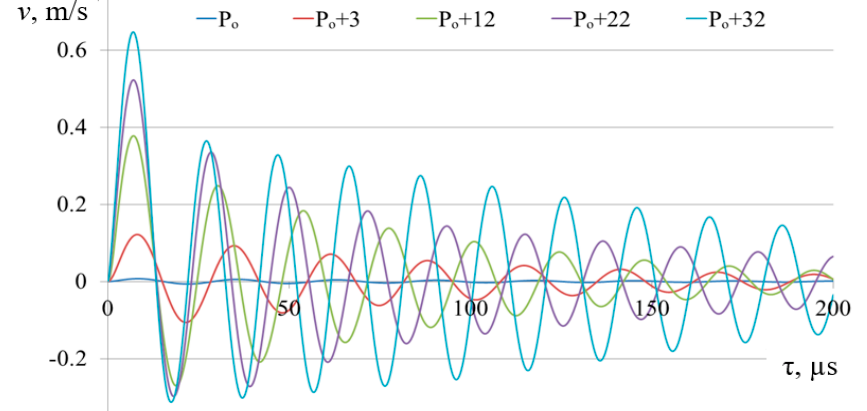
ff erent pressures, 10 5